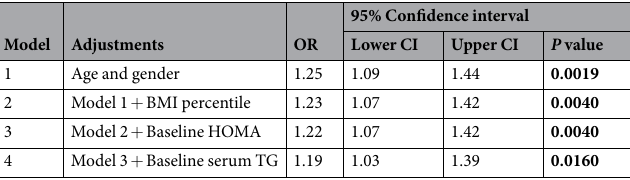
Table 2. Associations between baseline amino acid signature and odds of hypertriglyceridemia, adjusting for gender and baseline age, BMI percentile, HOMA and serum TG. All models were adjusted by sampling calendar year. Significant P-values are shown in bold.